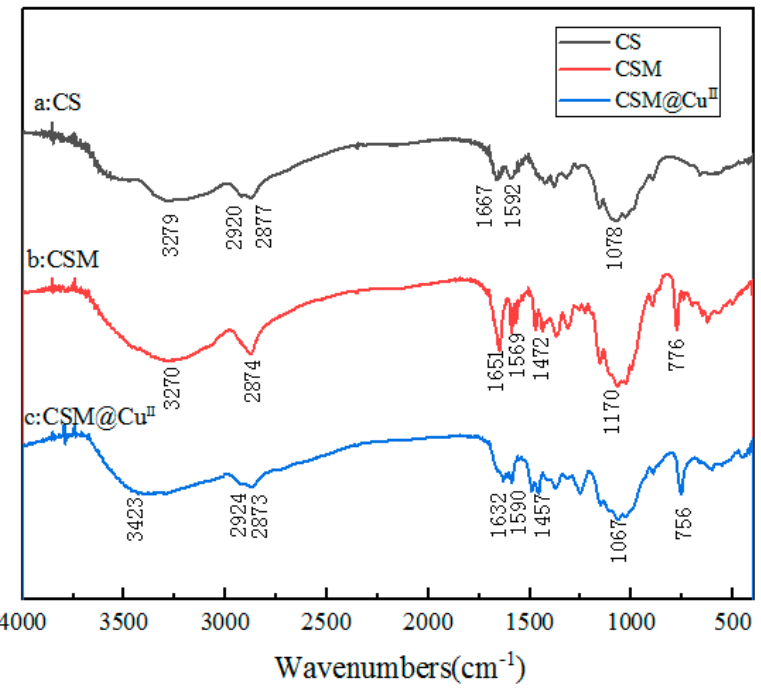
Figure 5. Fourier Transform Infrared Spectroscopy (FTIR) spectra of di ff erent compounds: ( a ) chitosan (CS), ( b ) modified chitosan microspheres (CSM), and ( c ) Cu 2 + -loaded modified chitosan microspheres (CSM@ Cu II ) .